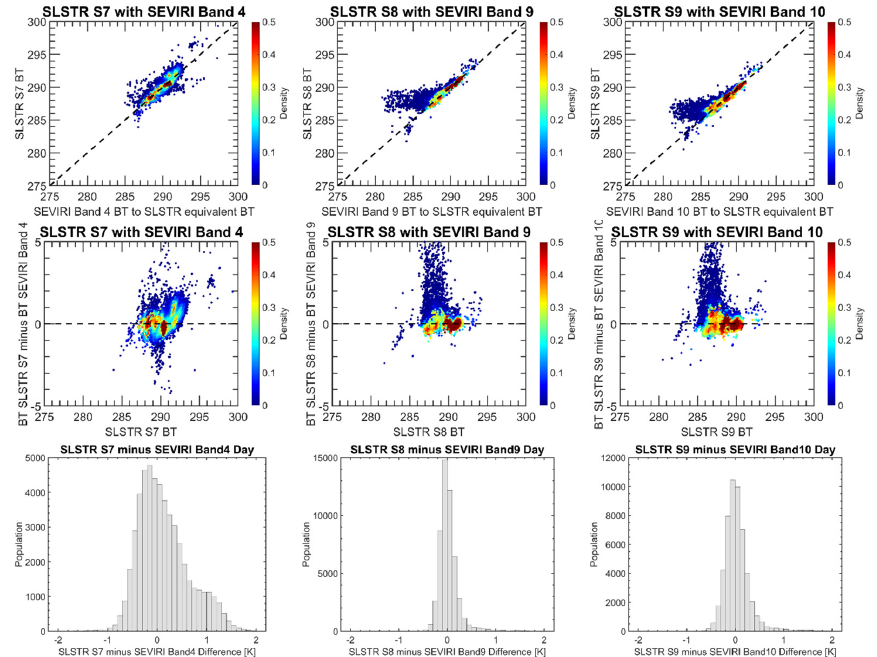
Figure 11. First row: scatter plot of the SLSTR BTs with SEVIRI equivalent BTs of each channel pair. The colors show the density of the data according to the right scale. Second row: scatter plot of the SLSTR BT with SLSTR minus SEVIRI BT of each channel pair. Third row: histograms of the BT differences of SLSTR minus SEVIRI for each channel pair. All of the SEVIRI BTs indicate the transferred SLSTR ‐ equivalent BTs. The BTs are divided into 0.5 K intervals.